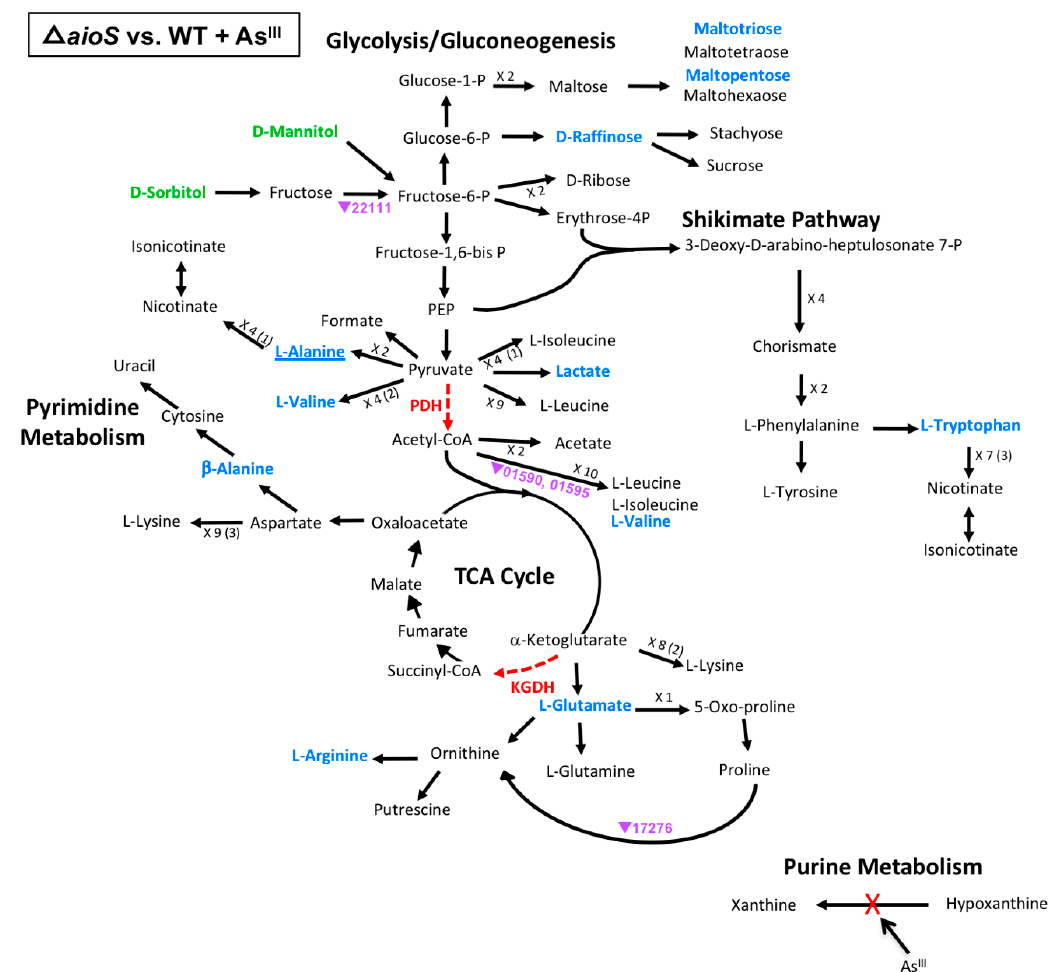
Figure 4. Model of carbon metabolism in the ∆ aioS mutant vs WT during As III exposure, with mannitol being the initial substrate. Reaction steps were derived from KEGG pathway maps using the most parsimonious routes of metabolite formation, noting that not all enzyme reaction steps are depicted in the model. When multiple intermediates are involved between illustrated metabolites, the number of reactions is shown; i.e., × 3, with the number of intermediates identified shown in parentheses. Green text denotes metabolites increased in abundance; blue text denotes metabolites decreased in abundance. Red dashed vector arrows indicate reactions suggested to be inhibited by As III . Transcripts are denoted by AT5A identification number (purple text), with a triangle indication increased expression ( ← ) or decreased expression ( ↔ ). Underlined text indicates metabolites or transcripts for which the change in abundance when compared to the WT was the same with or without As III .